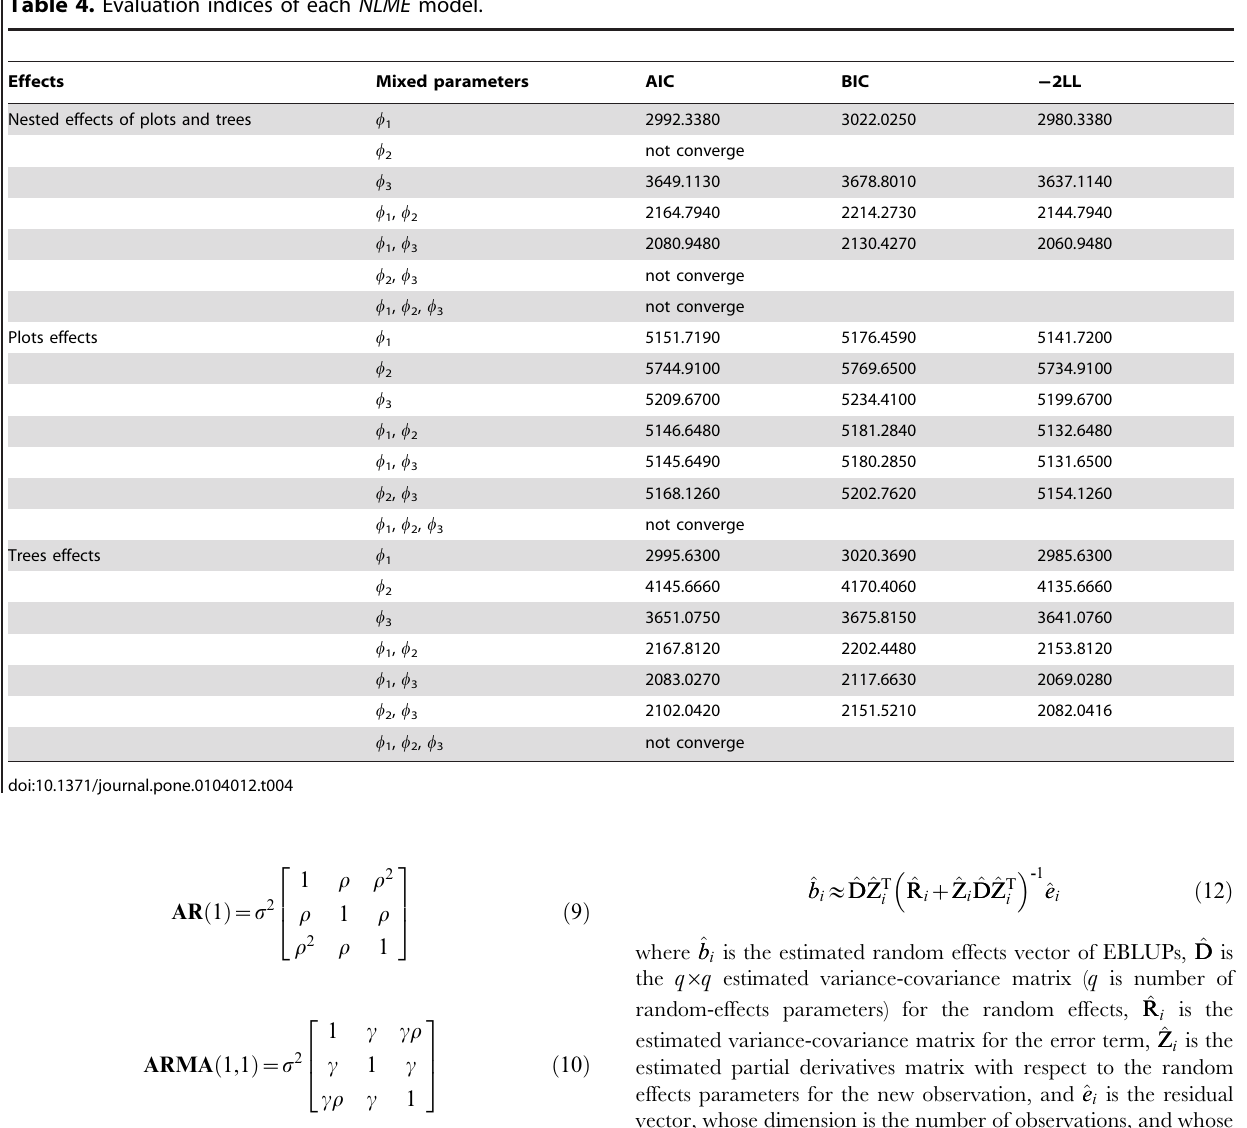
Table 4. Evaluation indices of each NLME